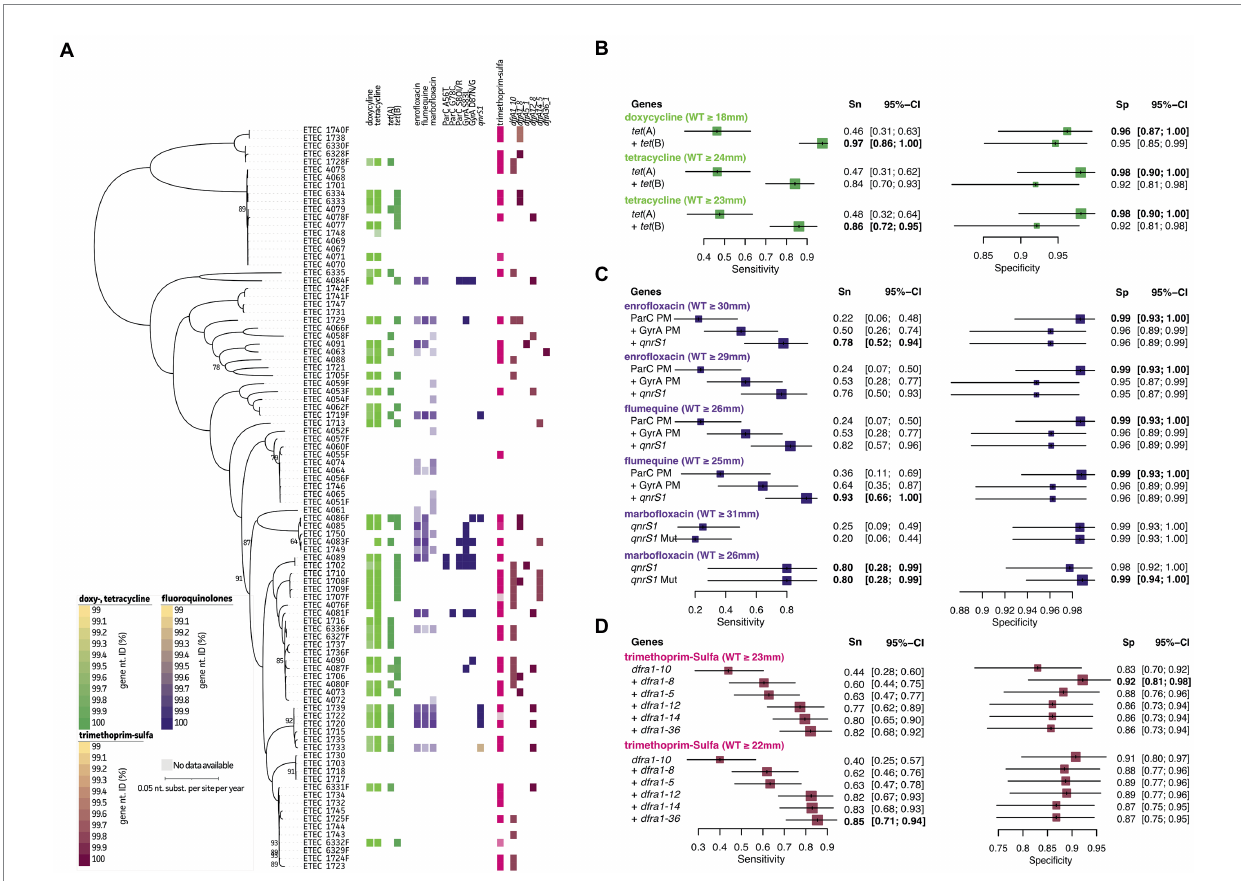
FIGURE 4 Association analyses for phenotypic and genotypic antimicrobial resistance of tetracyclines, fluoroquinolones, and trimethoprim-sulfa. (A) Maximum Likelihood (ML) tree showing strain relatedness and distribution of resistance phenotypes and genetic markers. Resistance phenotypes are shown based on NRI ECOFF values in which white and colored boxes represent WT and non-WT population, respectively. From left to right; doxycycline and tetracycline phenotypes, tet genes, enrofloxacin, flumequine, and marbofloxacin phenotypes, ParC protein mutations, GyrA protein mutations, qnrs1 gene, trimethoprim-sulfa phenotypes, and dfrA genes. Color grades for genes indicate nucleotide identities (%) as indicated in the legends at the left bottom. (B–D) Forest plots of predictive measures for selected genetic markers and ECOFF diameter cut-offs for the observed phenotypes (disc diffusion diameters (mm) or μ g.mL − 1 for colistin only). Forest plots show Sensitivity (Sn) and Specificity (Sp) measures and their 95% confidence